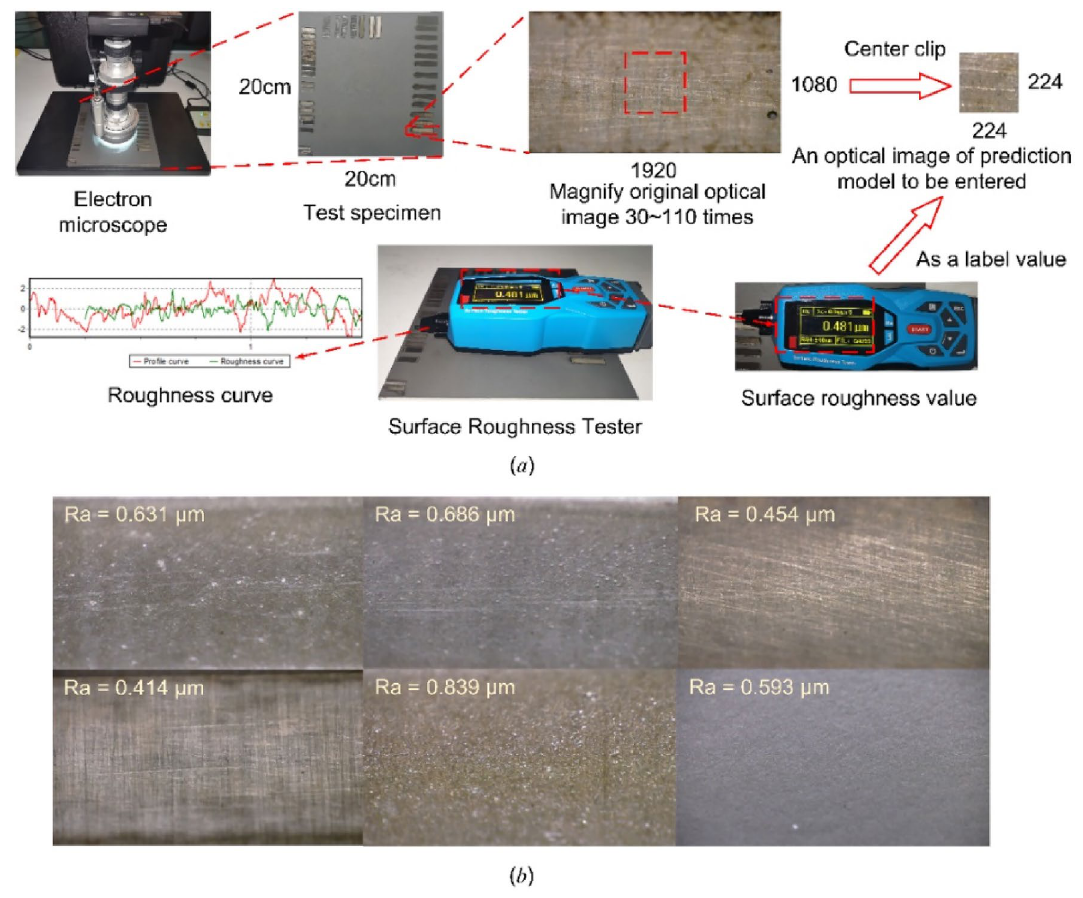
Figure 1. ( a ) Dataset construction process. ( b ) Partial original